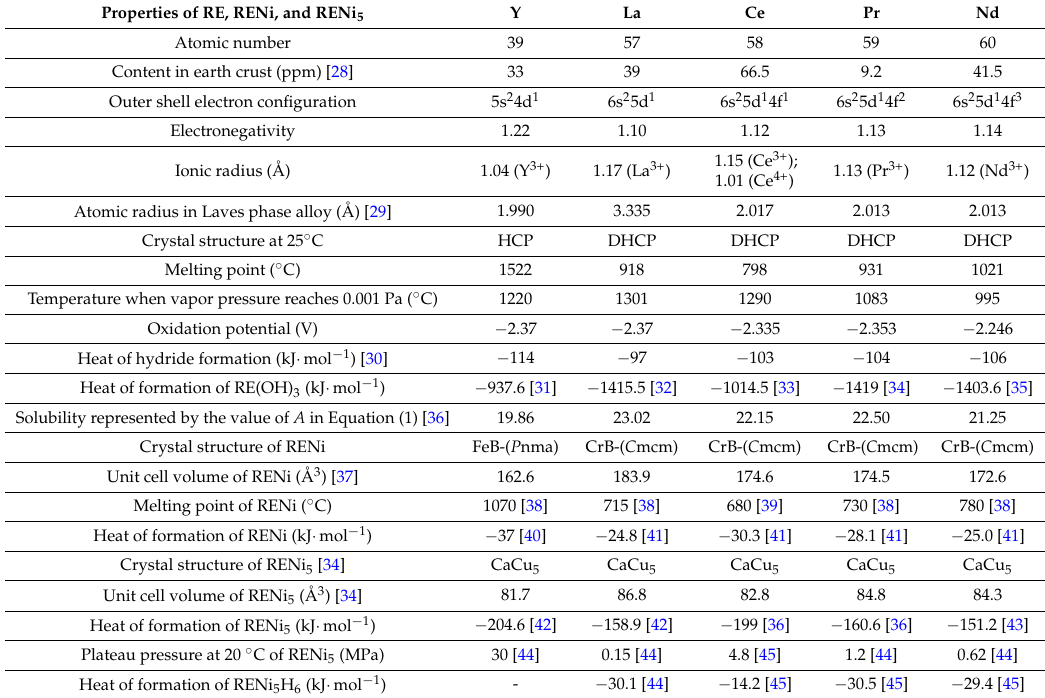
Table 1. Properties of the rare earth (RE = Y, La, Ce, Pr, and Nd) elements, RENi and RENi 5 intermetallic compounds. Data are from [27] unless otherwise cited. HCP and DHCP denote hexagonal close packed, and double- c hexagonal close packed, respectively.